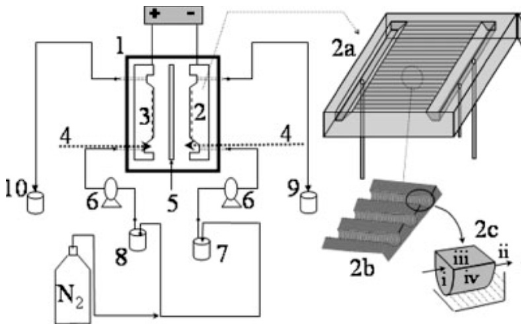
Figure 5. A schematic of a filter-press microreactor. Reprinted from [143] Copyright (2020), with permission from John Wiley and Sons.